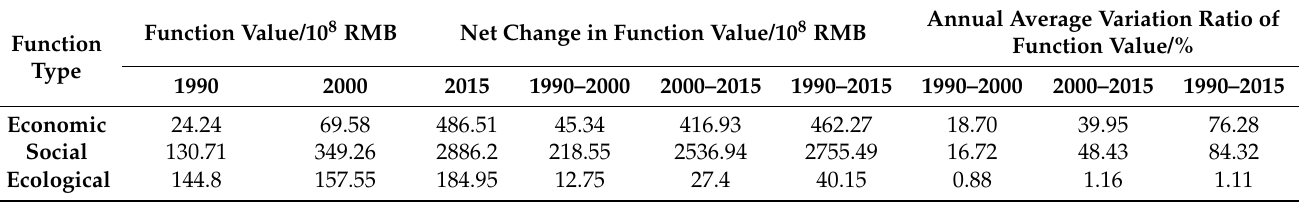
Table 2. Variation in the value of LUFs in the whole case study area of Zhangjiakou City